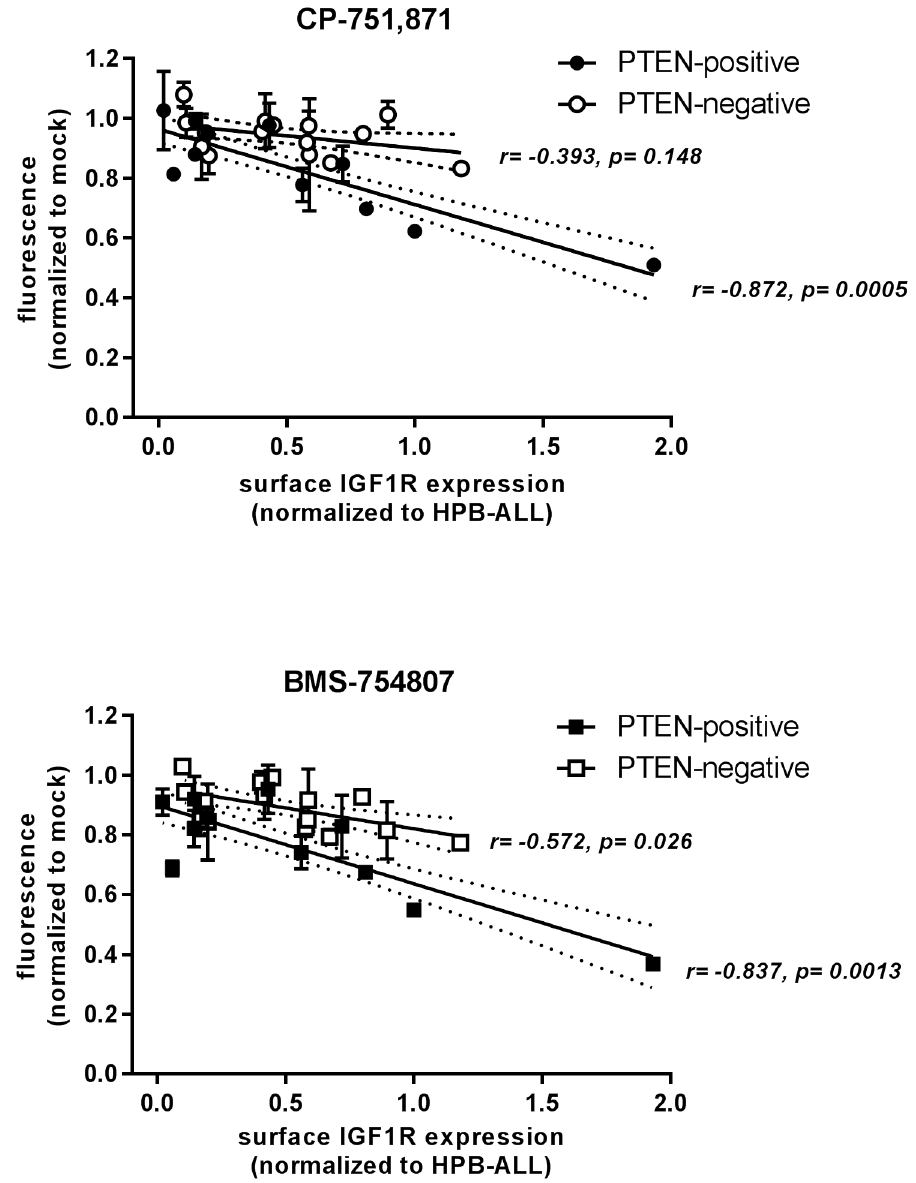
Fig 4. Correlation between IGF1R inhibitor efficacy and surface IGF1R expression level holds up in PTEN-positive cell lines, but less so in PTEN-negative cell lines. Linear regression lines are shown separately for PTEN-positive and -negative subsets, with 95% confidence intervals indicated by flanking dotted lines. Pearson correlation r values and associated significance p-values are indicated for each subset. Plotted data are identical to those presented in Fig 2, but now segregated into PTEN-positive and -negative subsets .